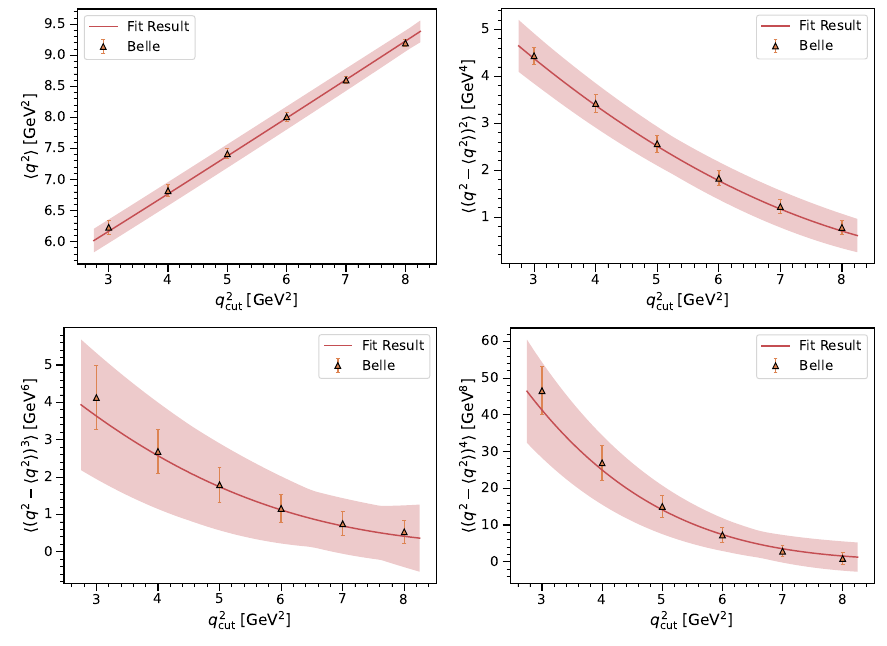
Figure 15 . Fit projections for q 2 moments using Belle data